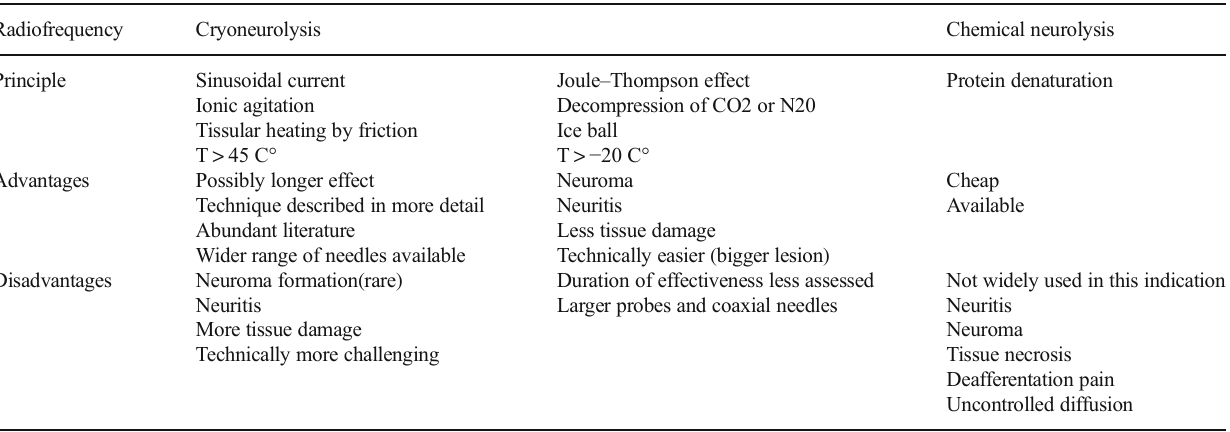
Main characteristics of the denervation procedure